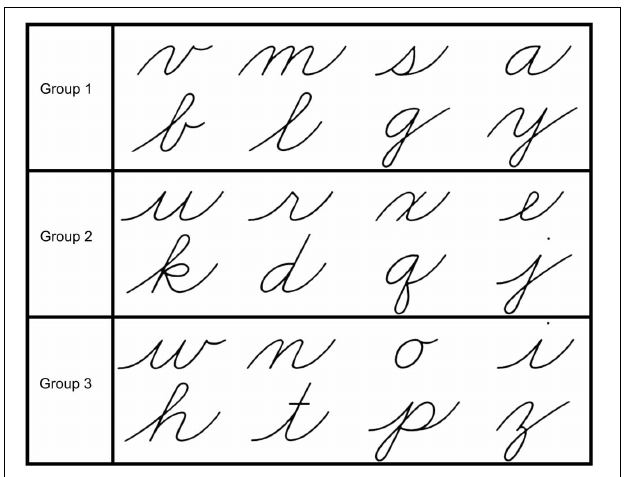
FIGURE 1 | Cursive stimuli divided into groups used for assignment of letters to learning